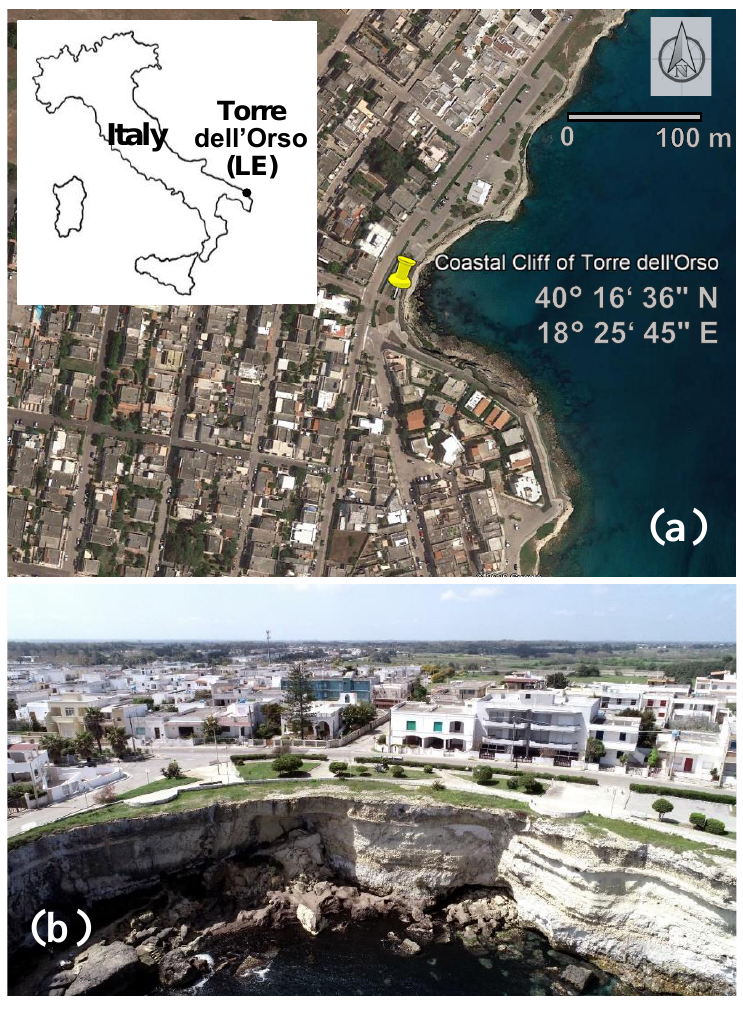
Figure 1. Coastal cliff of Torre dell’Orso; ( a ) location and site coordinates (Google Earth ® ); ( b ) panoramic view. Remote Sens. 2020 , 12 , x FOR PEER REVIEW